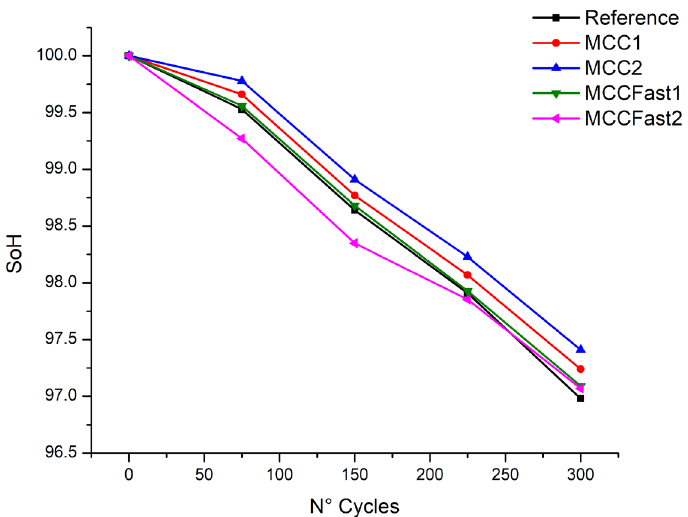
Figure 11. SoH as a function of the number of cycles for different charging